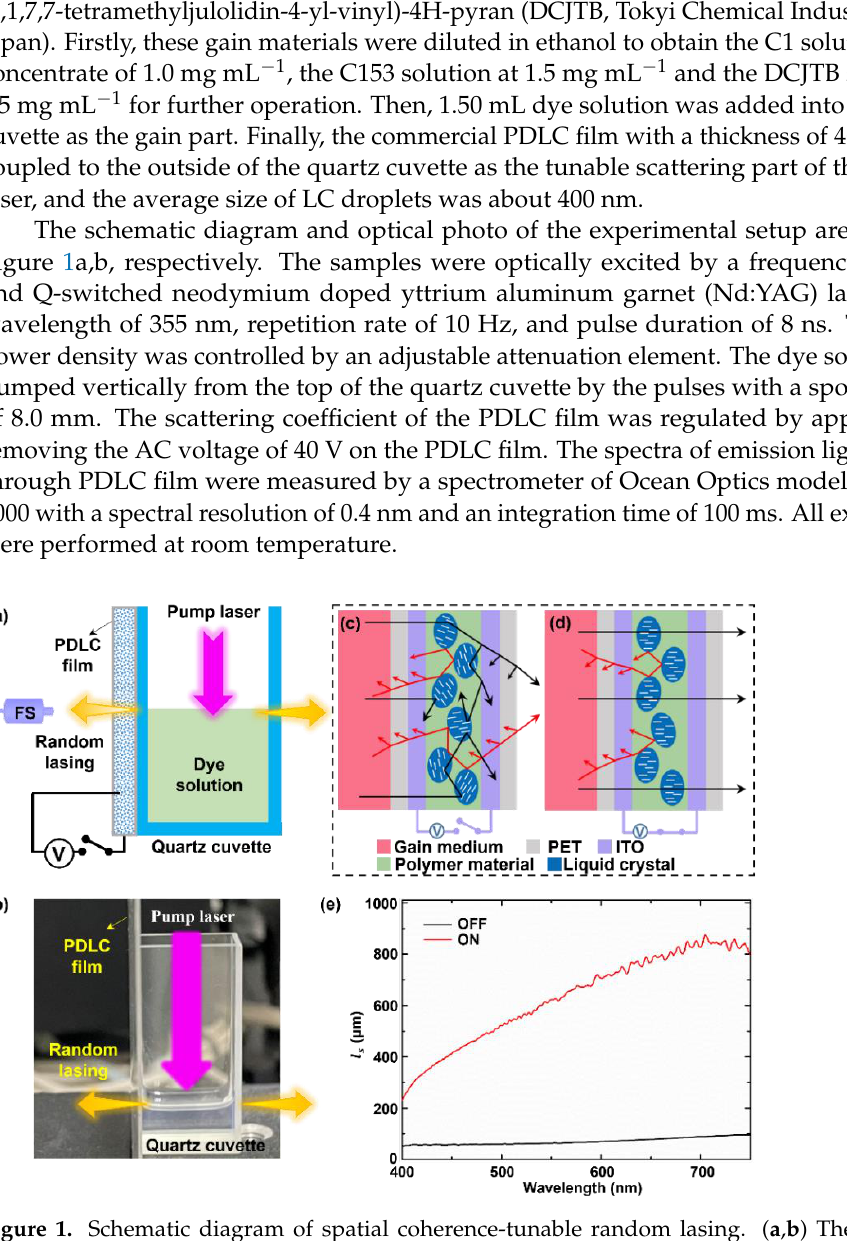
Figure 1. Schematic diagram of spatial coherence-tunable random lasing. ( a , b ) The schematic diagram ( a ) and the optical photo ( b ) of the experimental setup. ( c , d ) The emission principle diagram of random lasing in the coupling system with the gain medium and the PDLC film without ( c ) and with ( d ) the external electric field. ( e ) The calculated scattering mean free path ( l s ) when the electric field was switched on (ON) and switched off (OFF),